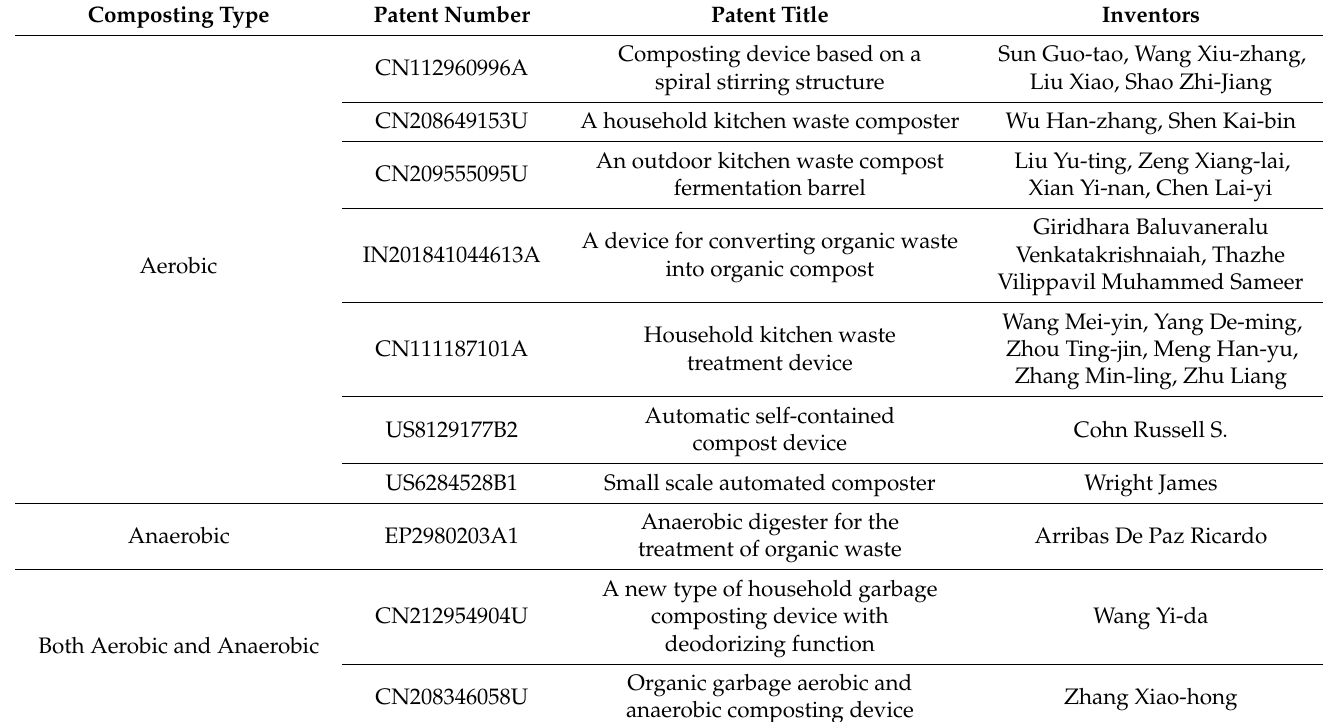
Table 11. Classification of the fully automated composting